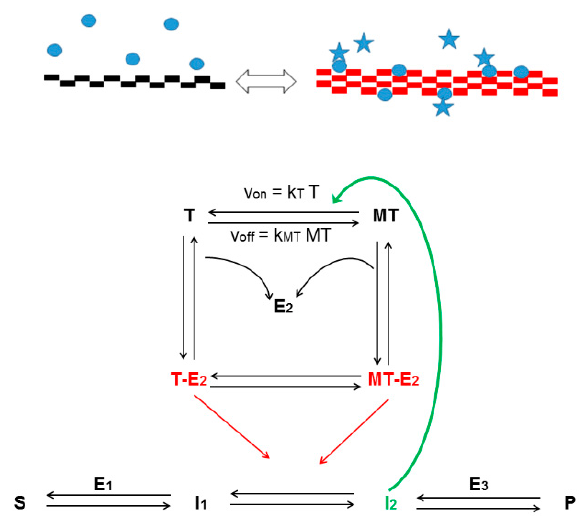
Figure 6. Sensor potency of the enzyme-decorated microtubule network that acts on the dynamics of the microtubule (MT) system (rectangles) and the regulation of the metabolic pathway catalyzed by enzymes (E, blue circles), when these enzymes are either active (presence of star) or inactive. S: substrate, I 1 and I 2 : intermediates, P: product.